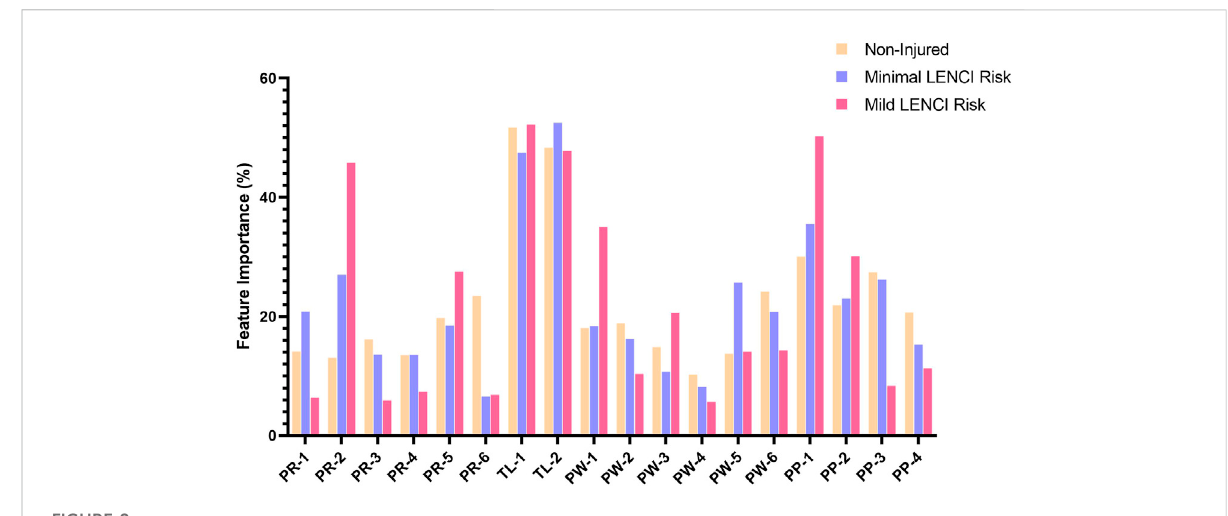
FIGURE 8 The feature importance of each